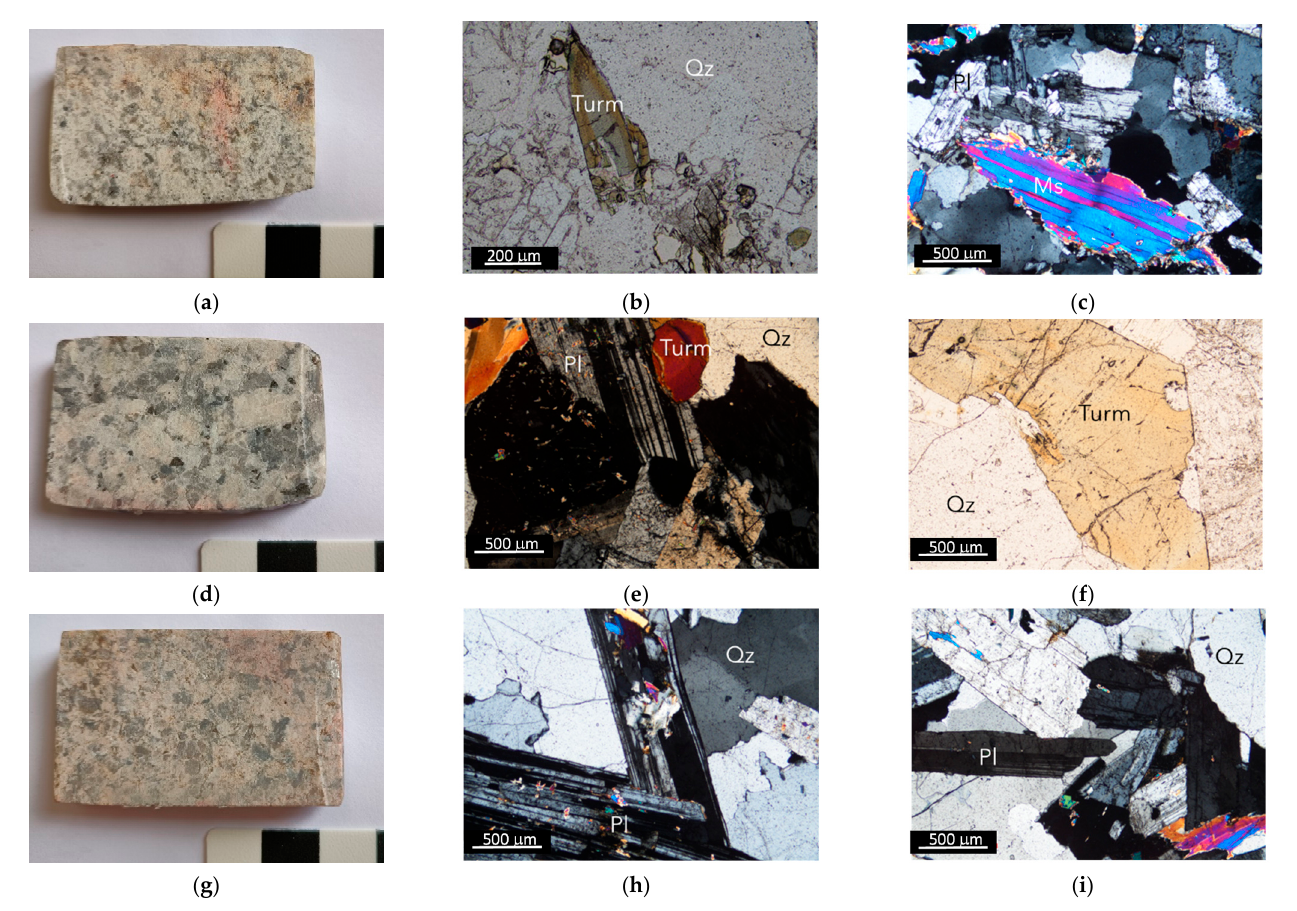
Figure 3. Macroscopic and photomicrographs of samples of the different facies of Regoufe granite: ( a ) medium-grained muscovite-albite granite hand sample; ( b ) K-feldspar, quartz and muscovite; ( c ) deformed muscovite; ( d ) tourmaline-bearing porphyritic two-mica granite hand sample; ( e ) sericitization of plagioclase and tourmaline; ( f ) large crystal of tourmaline; ( g ) non-uniform mineralogical transition zone hand sample; ( h ) sericitization of plagioclase and quar tz ; and ( i ) quar tz , plagioclase and muscovite. Sub fi gures ( b , c , e , h , i ) were taken in crossed-polar and ( f ) in plane-polarized light. Qz—quar tz , Ms—muscovite, Pl—plagioclase, Fsp-K—K-feldspar, Turm— tourmaline.